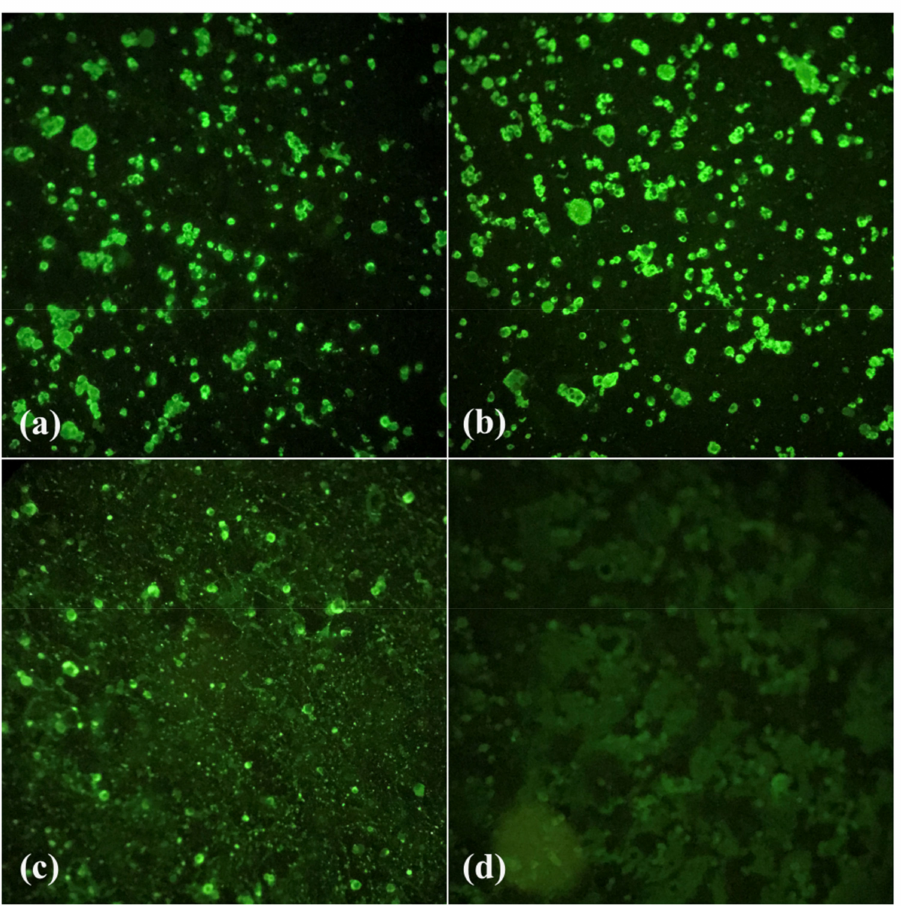
Figure 2. Indirect immunofluorescence of Culex quinquefasciatus body and head samples from Á guas Lindas neighborhood (group 1). ( a ) Positive 14th dpi body sample; ( b ) Positive 21st dpi head sample; ( c ) Positive control; ( d ) Negative control. Images were taken at 200 × magnification. The infection rate in G1 was 100% in the three dpi analyzed and in G2 was 84% at 7th, 96% at 14th, and 100% at 21st dpi. Thus, the total infection rate was 92% positive bodies on the 7th dpi, 98% on the 14th dpi, and on the 21st dpi all bodies (100%) were positive for WNV infection. The Chi-square ( X 2 ) test was not performed to analyze the infection rate of G1. All dpis had 100% positivity. In G2 ( p = 0.0344, A = 3.7101), there was an increasing trend in the number of positive body samples as the day post-infection increased. The dissemination rate for G1 was 0% at 7th dpi, 33% at 14th dpi, and 100% at 21st dpi. In G2, it was 29% at 7th dpi, 33% at 14th dpi, and 62% at 21st dpi. Thus, the total dissemination rate was 13% at 7th dpi, 33% at 14th dpi, and 80% at 21st dpi (Figure 4b). X 2 showed an increasing trend (G1: p = 0.0001, A = 22.7125; G2: p = 0.0279, A = 7.0000) in the number of positive head samples with increasing dpi in both